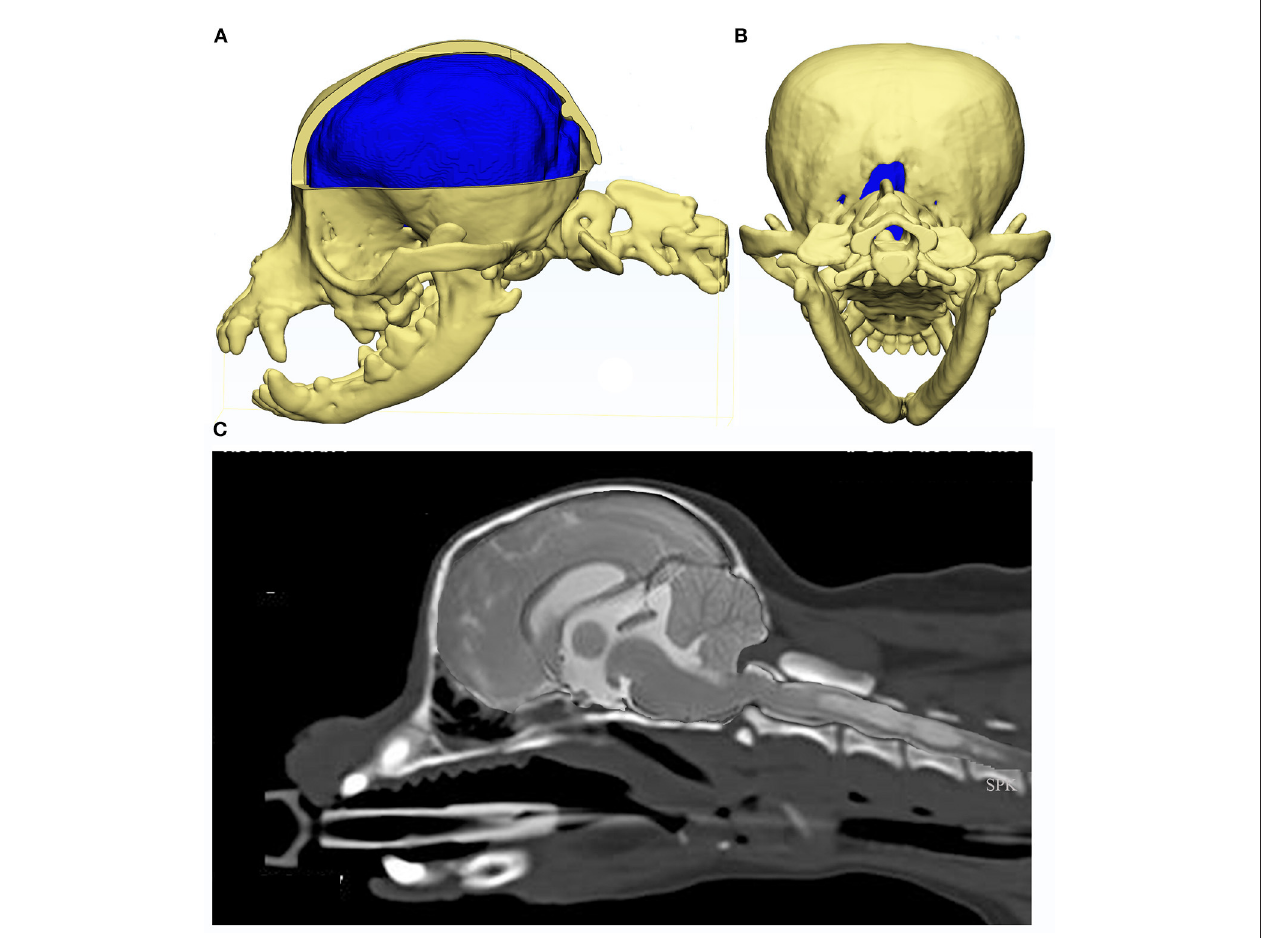
FIGURE 6 | Constructed images using CT and MRI of the skull, brain and craniocervical junction of a Chihuahua with CM and SM. MRI and CT of a 5 year old female Chihuahua with CM and SM are used to construct images to illustrate the complexity of the skull, craniocervical junction and neuroparenchymal malformation. Top row: 3d models (Courtesy of Dr. Cameron Black, Clinical Research Officer, Fitzpatrick Referrals Ltd.) (A) cerebellum is invaginated under the occipital lobes with little space available for this organ. Much of the atlas is rostral to the level of the occipital crest. (B) caudal view of the skull with the supra-occipital bone missing either because it did not form in the first instance or was resorbed due to pressure necrosis. Bottom row: (C) composite of midsagittal brain and cervical MRI and CT with the short skull base and complex craniocervical junction abnormality with overall reduction of volume, loss of the cisterna magnum and medullary elevation over a dorsally angled